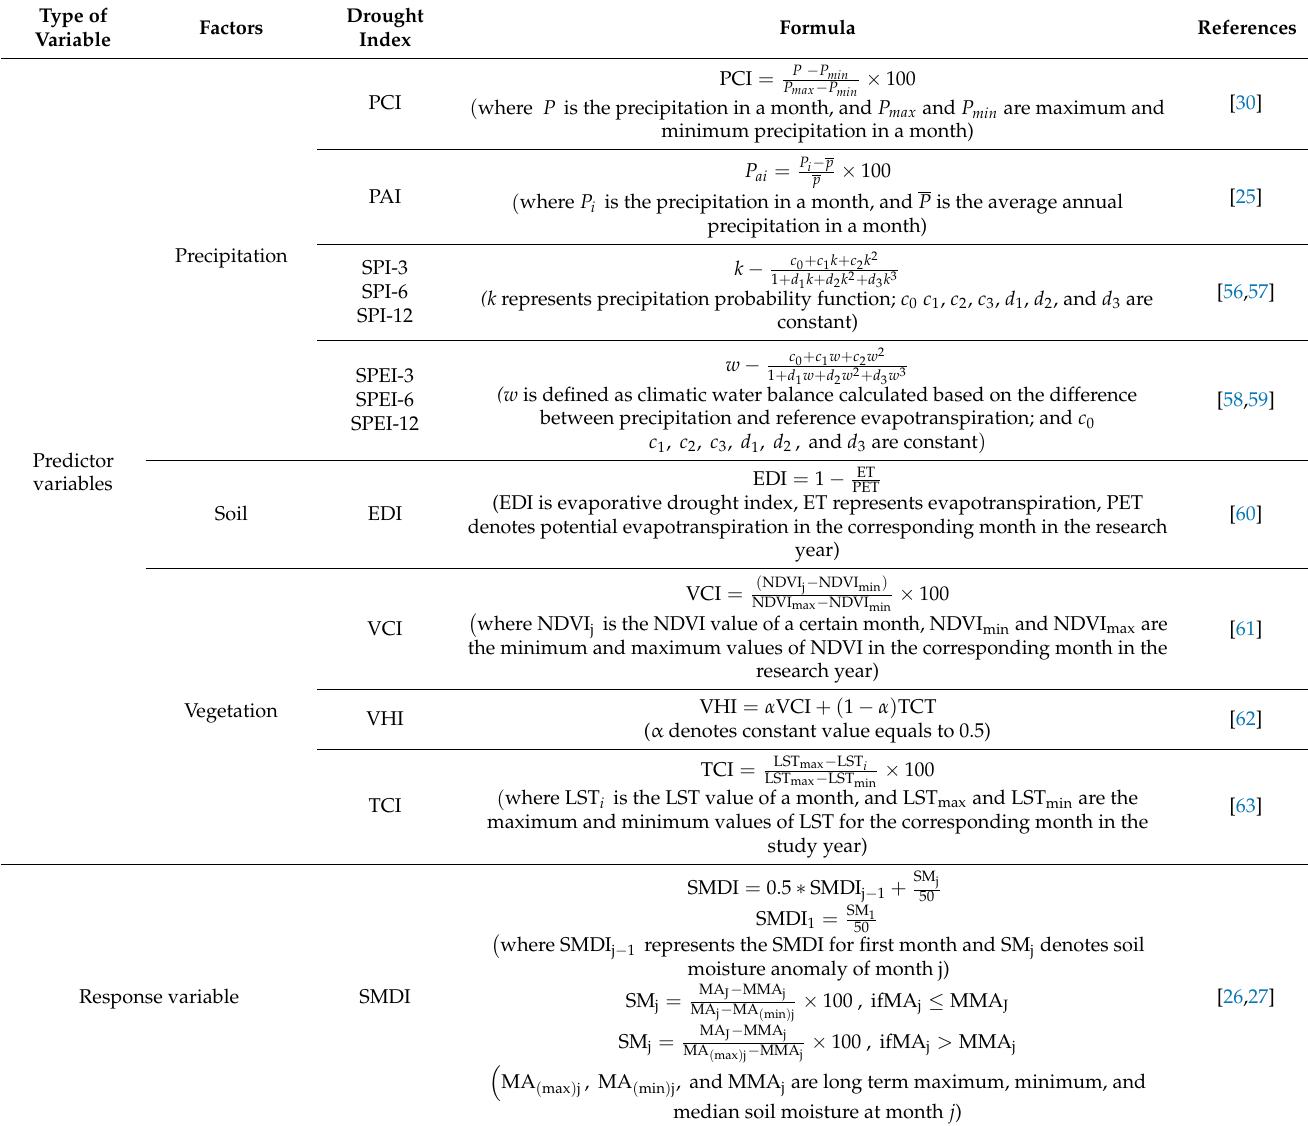
Table 2. Description of the input